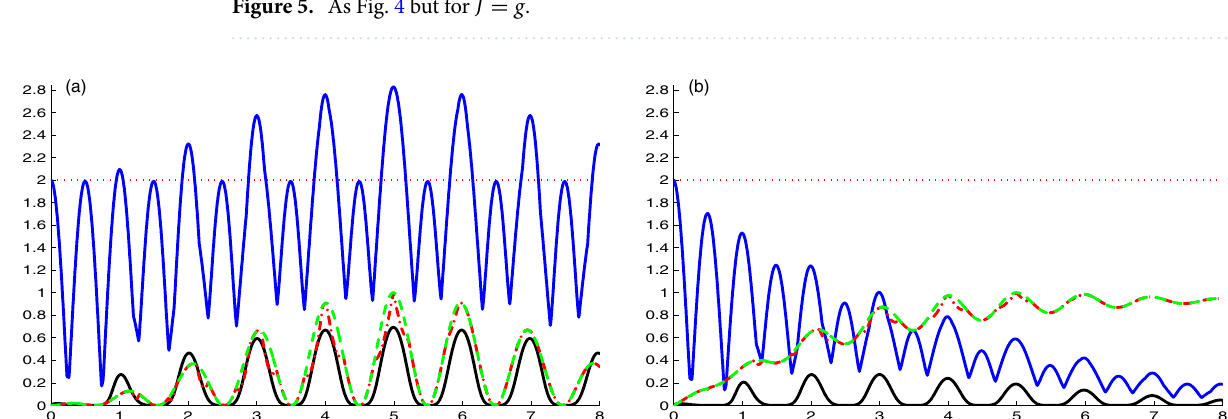
Figure 5. As Fig. 4 but for J